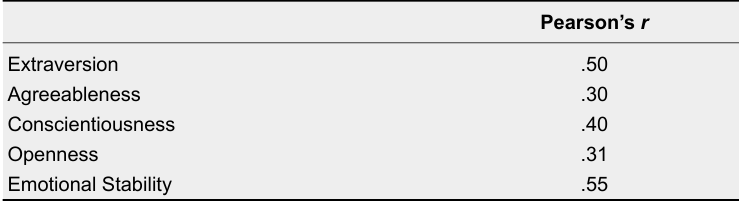
Correlations Among Trait Pairs for Big Five Traits (N =